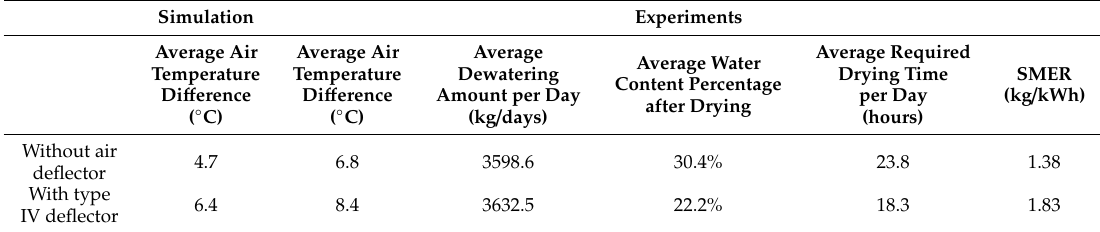
Table 3. Evaluation of the di ff erence between the two cases with or without air